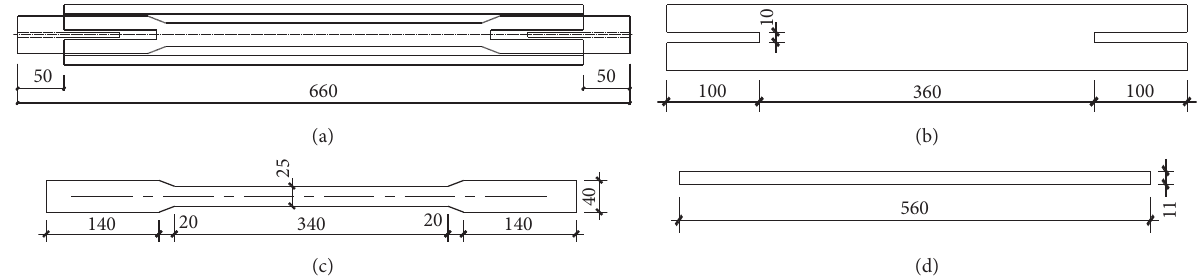
Figure 5: Details of BRB (mm). (a) Overall drawing of BRB. (b) Restraining plate 1 with a thickness of 10mm. (c) LYP core with a thickness of 5mm. (d) Restraining plate 2 with a thickness of 11mm.